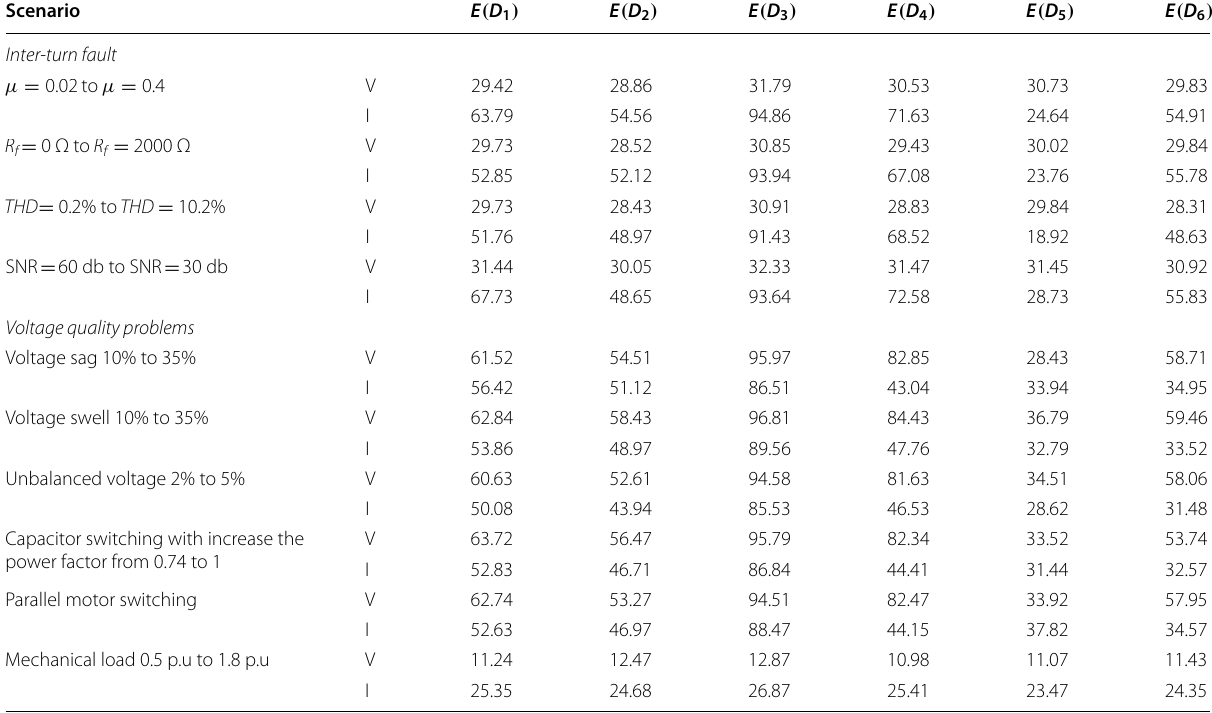
Table 2 The energy of different decomposed vectors Scenario Inter-turn